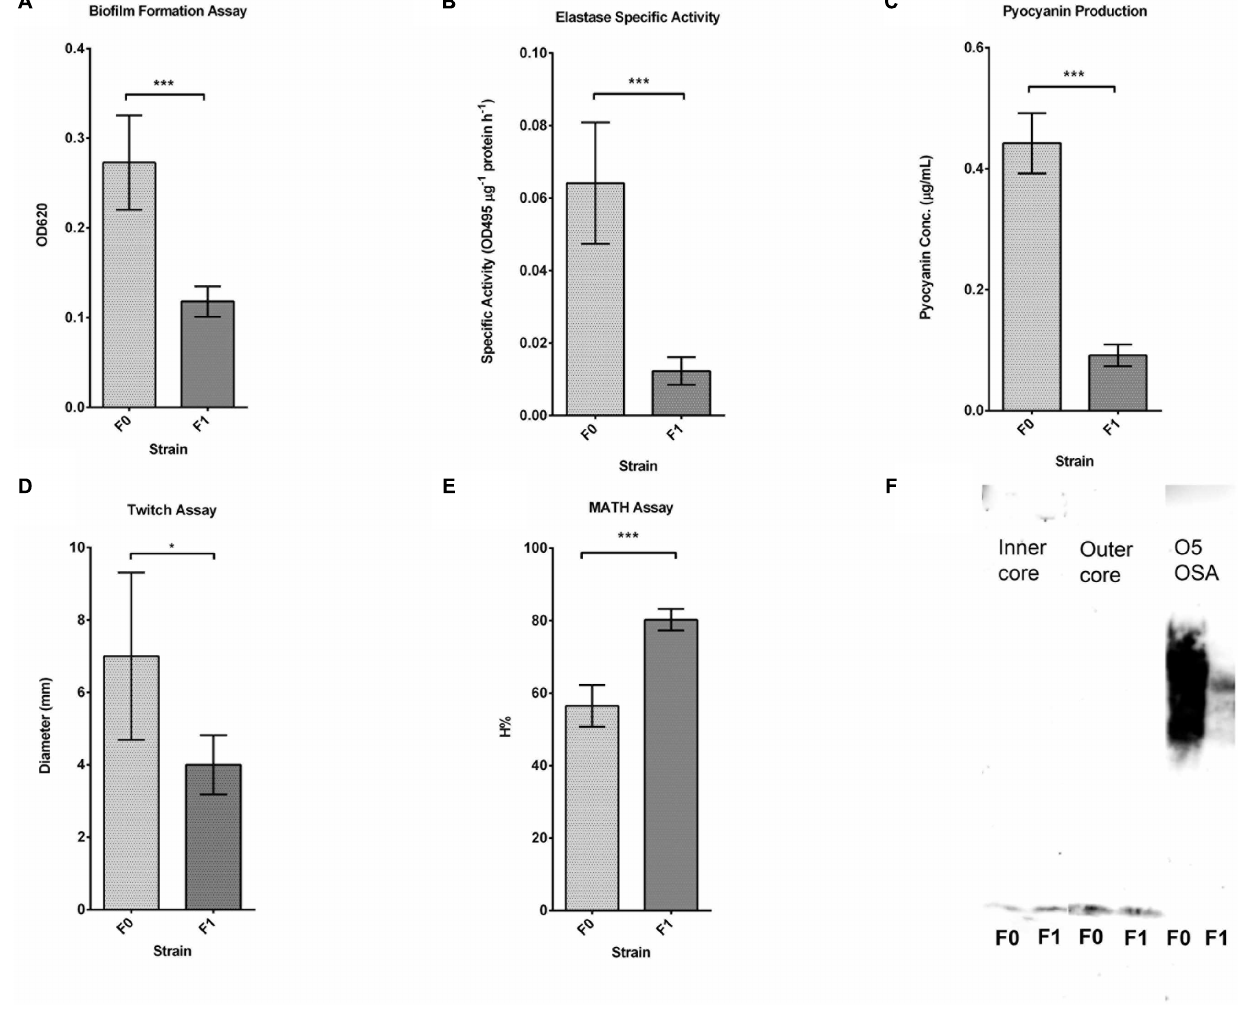
FIGURE 2 | Results for phenotypic assays. (A) Biofilm formation assay of three replicates of F0 and F1 strains; Student’s t -test. F1 cells have a significantly lower OD260 than F0, indicating fewer attached cells since fewer of them are stained. (B) Elastase assay of five replicates of F0 and F1 strains; Student’s t -test. F1 cells produce significantly lower elastase specific activity than F0. (C) Pyocyanin production assay of five replicates of F0 and F1 strains, measured concurrently with elastase activity; Student’s t -test. F1 cells produce significantly lower amount of pyocyanin than F0. (D) Twitch assay for seven replicates of F0 and F1 strains; Student’s t -test. F1 cells have a significantly lower twitching ability than F0. (E) MATH assay of 12 replicates of F0 and F1 strains; Student’s t -test. F1 cells have a significantly higher H% than F0 cells. (F) Western blot analysis of LPS preparations from F0 and F1 strains, tested using antibodies for inner, outer core and OSA. ∗ p < 0.05, ∗∗ p < 0.005, ∗∗∗ p <